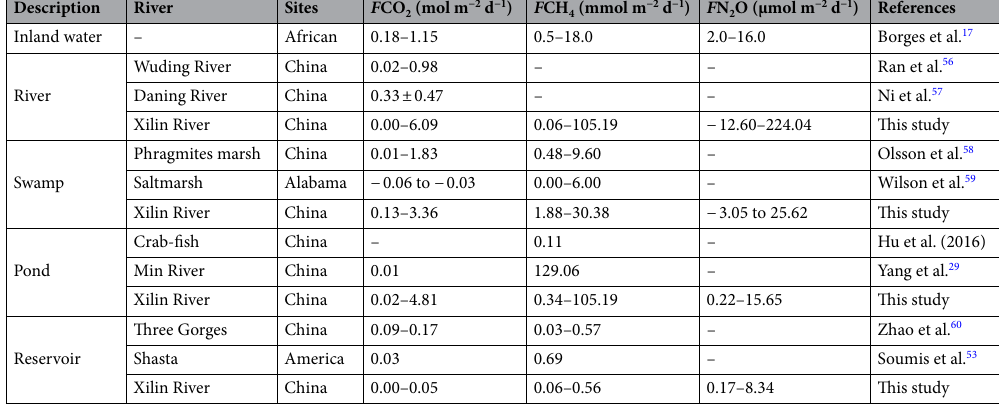
Table 3. Comparison of GHG emissions from river to